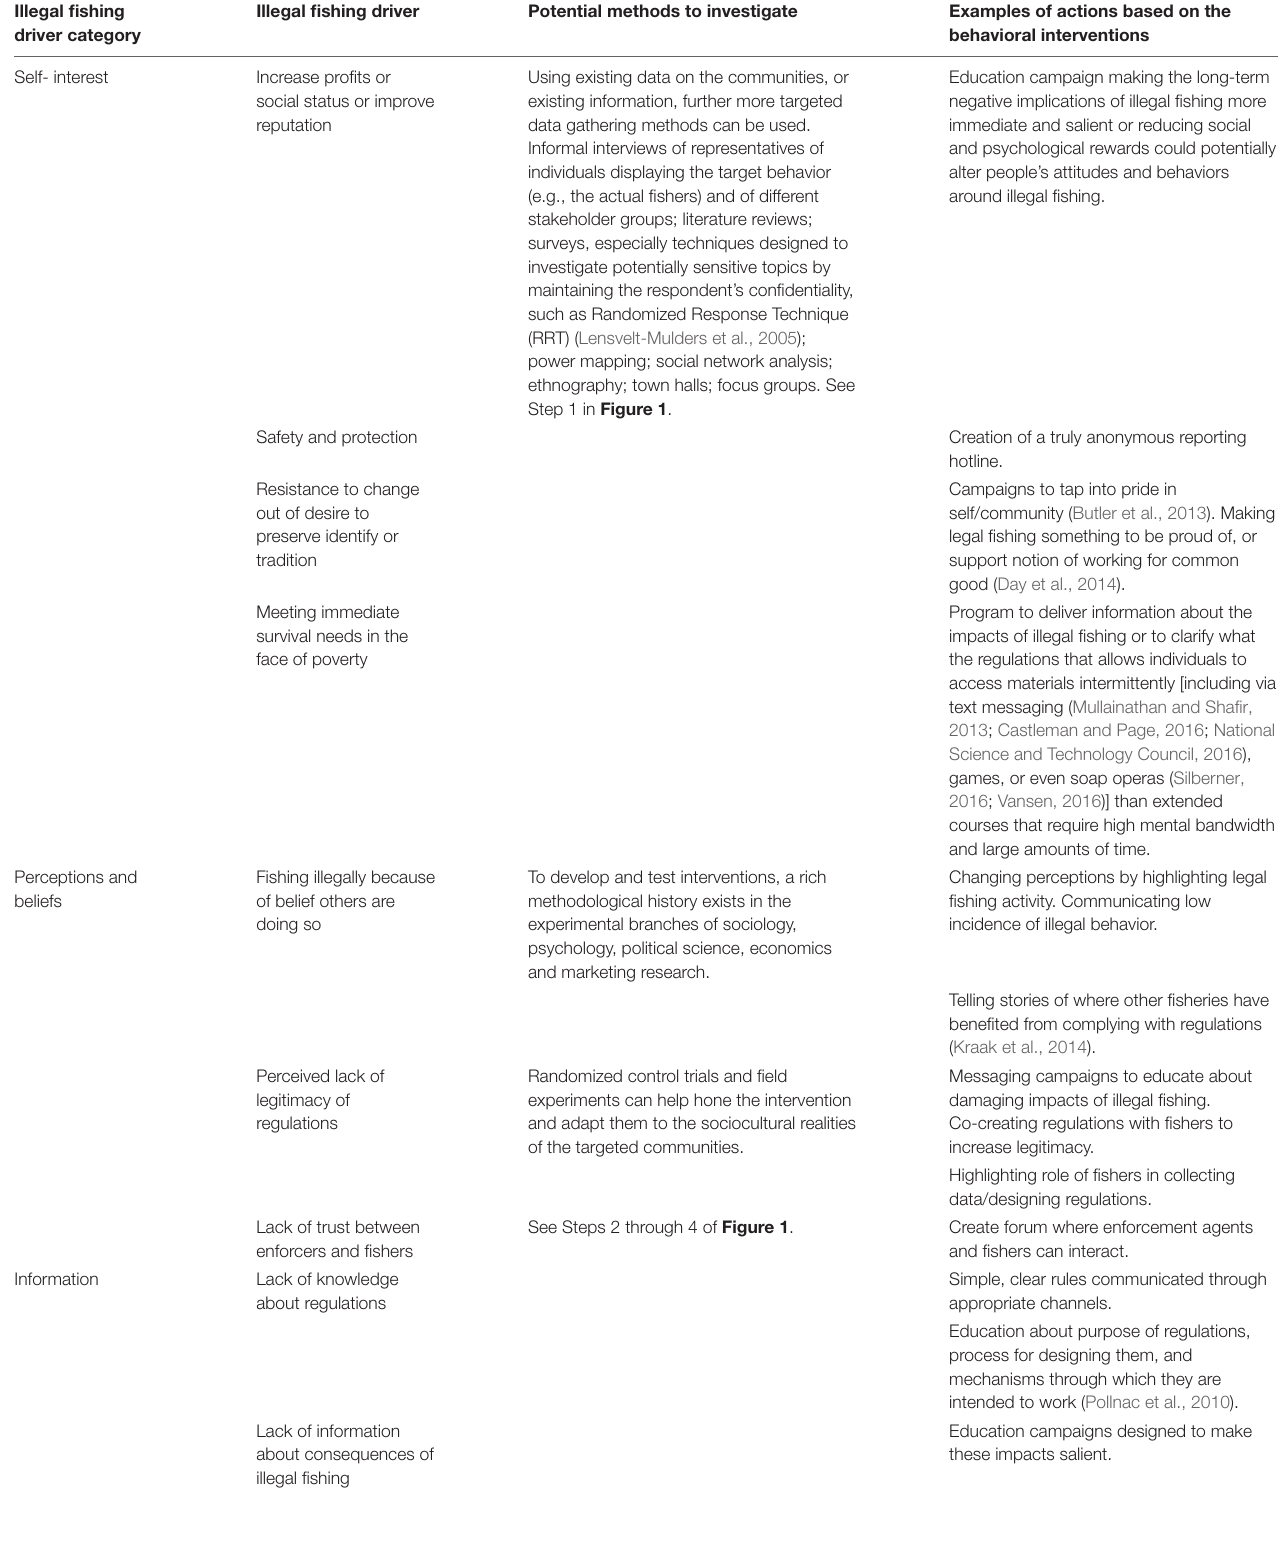
TABLE 1 | Categorized behavioral drivers of illegal fishing, potential methods to investigate, and potential intervention examples. Illegal fishing driver